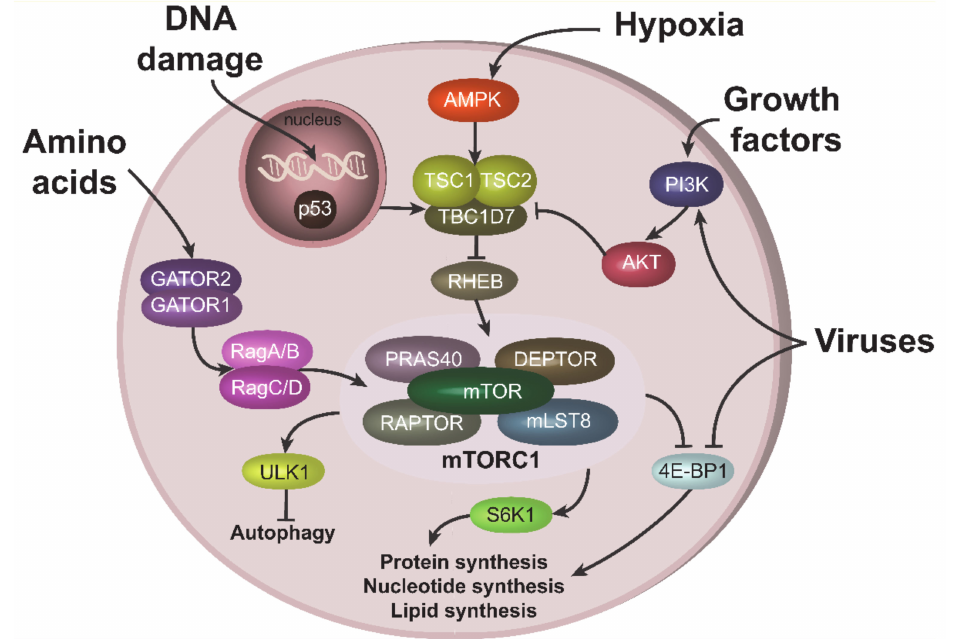
Figure 1. Upstream and downstream mTORC1 signaling. mTORC1 can be stimulated by various cues. Amino acids activate mTORC1 through GATOR1 / GATOR2 complexes and RAGs. Growth factors recruits PI3K to the plasma membrane, which results in subsequent AKT activation. AKT can stimulate mTORC1 either directly through the phosphorylation of its component PRAS40, or via phosphorylation and inhibition of TSC1 from the TSC complex, which leads to RHEB and mTORC1 activations. Under hypoxic condition, mTORC1 is repressed due to TSC activation via AMPK. TSC can also be stimulated (i.e., mTORC1 repressed) via p53 pathway during DNA damage. Viruses can activate mTORC1, especially at the late stage of infection, both upstream, via PI3K / AKT, or acting on downstream mTORC1 target